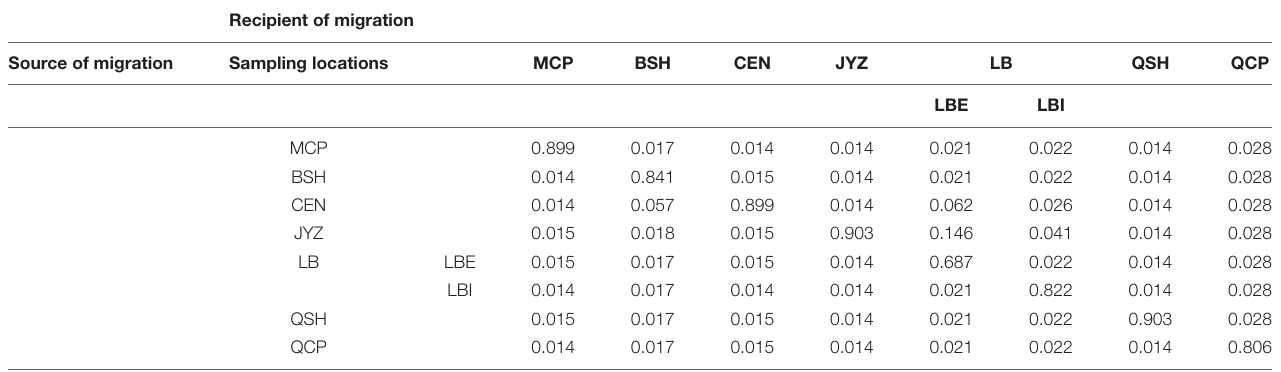
TABLE 1 | Recent migration rates between each sampling location and the two genetic groups in LB using the cross-validated SNPs from the Stacks data set. Recipient of migration